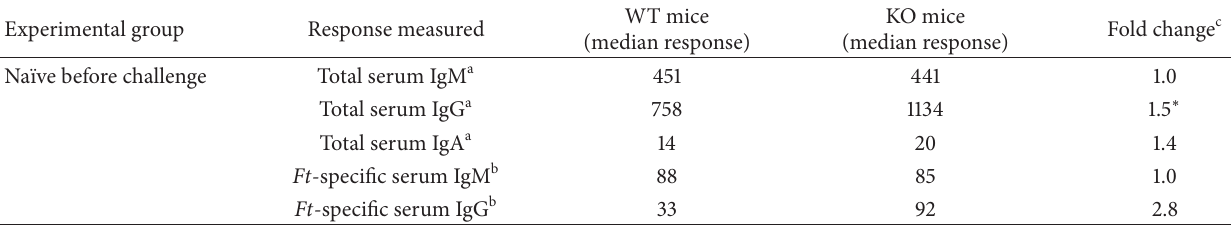
Table 1: Relative differences in Ab levels between na¨ıve WT and na¨ıve Fc 𝛾 RIIB KO